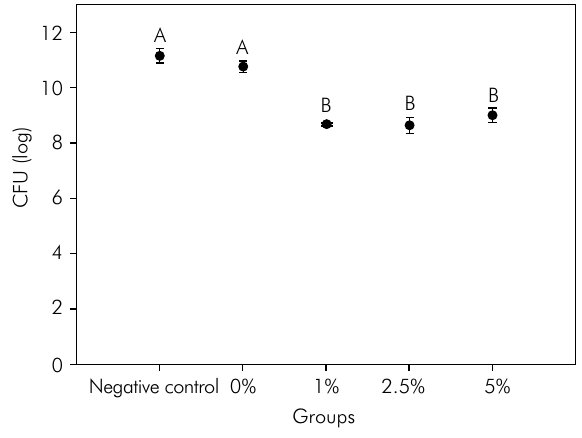
Figure 2. Figure 2. Median and 25th and 75th percentiles in CFU (log). Different uppercase letters indicate significant differences (p <